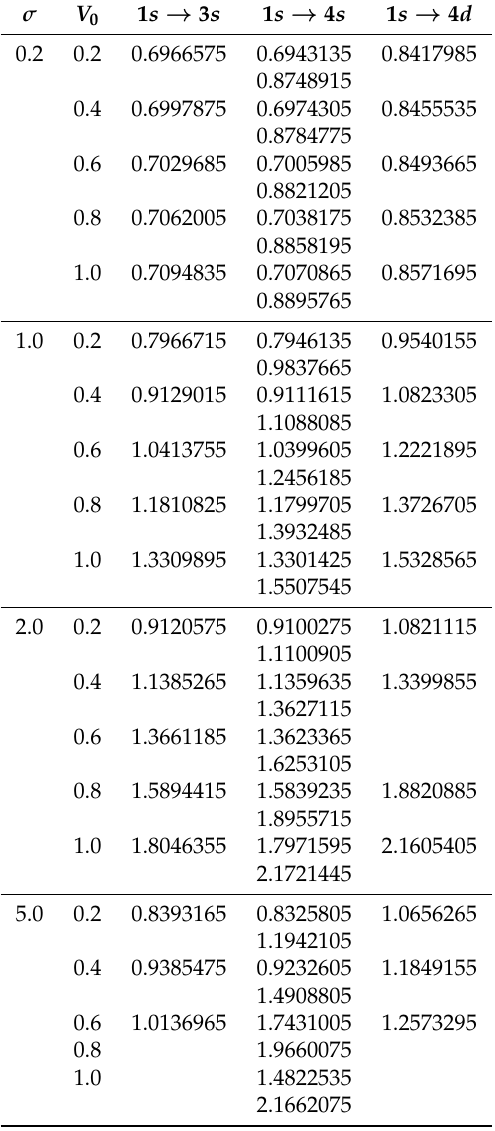
Table 2. Two-photon transparency frequencies for various potential widths and depths. The data is in atomic